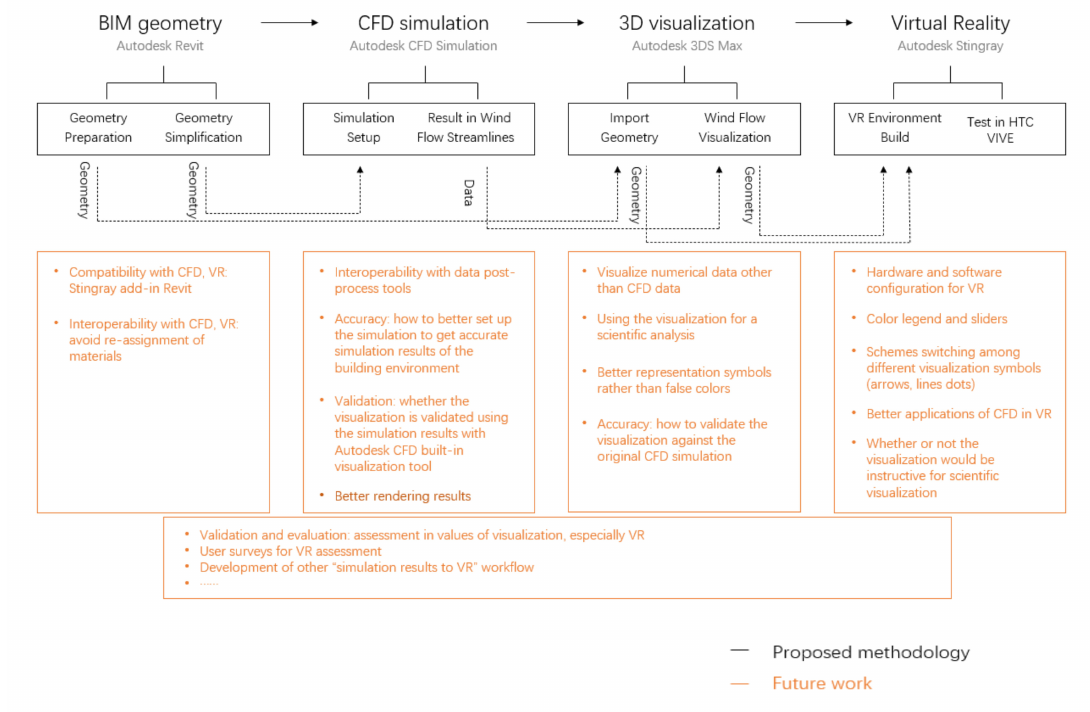
Figure 18. Possible future works motivated by this